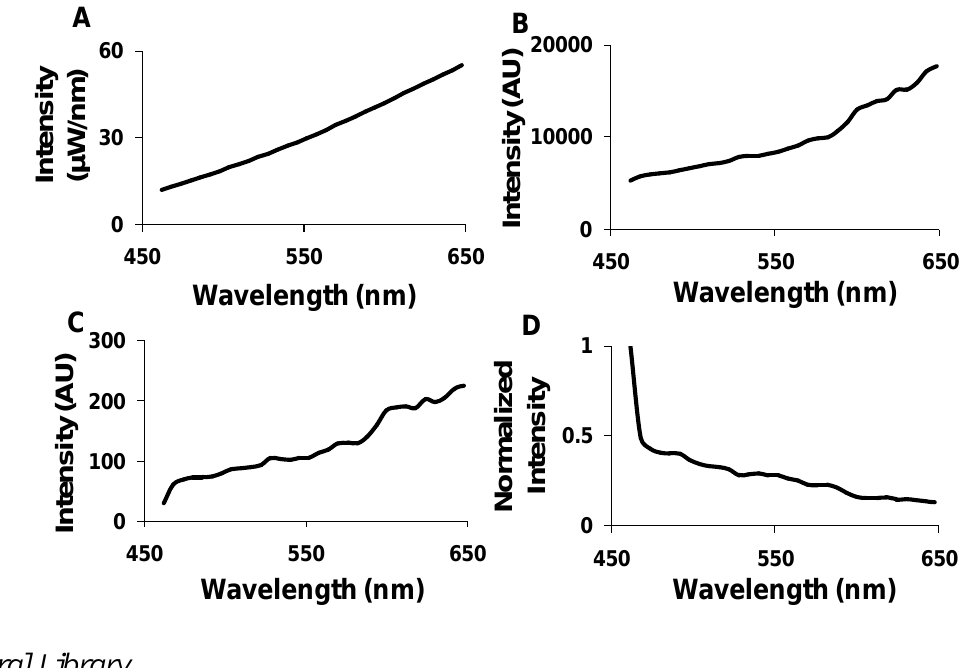
Figure 2. Flat spectral correction was used to compensate wavelength dependent-attenuation of fluorescence emission. ( A ) The spectrum of the US National Institute of Standards & Technology (NIST)-traceable lamp; ( B ) the spectrum of the NIST-traceable lamp as measured by the hyperspectral microscope; ( C ) the transfer function of the hyperspectral microscope; ( D ) the correction coefficient to perform flat-field